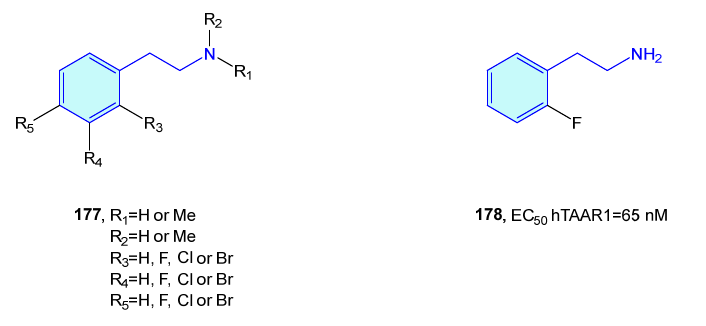
Figure 23. 2-Phenethylamines with hTAAR1 bioactivity.